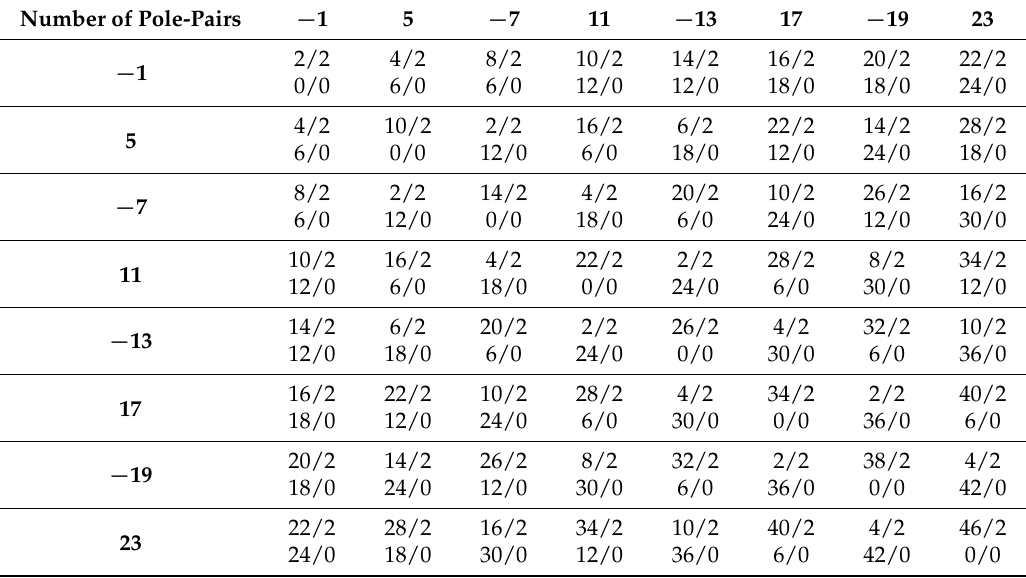
Table 4. The radial electromagnetic force in the air gap produced by the armature reaction magnetic field alone (mode number/frequency